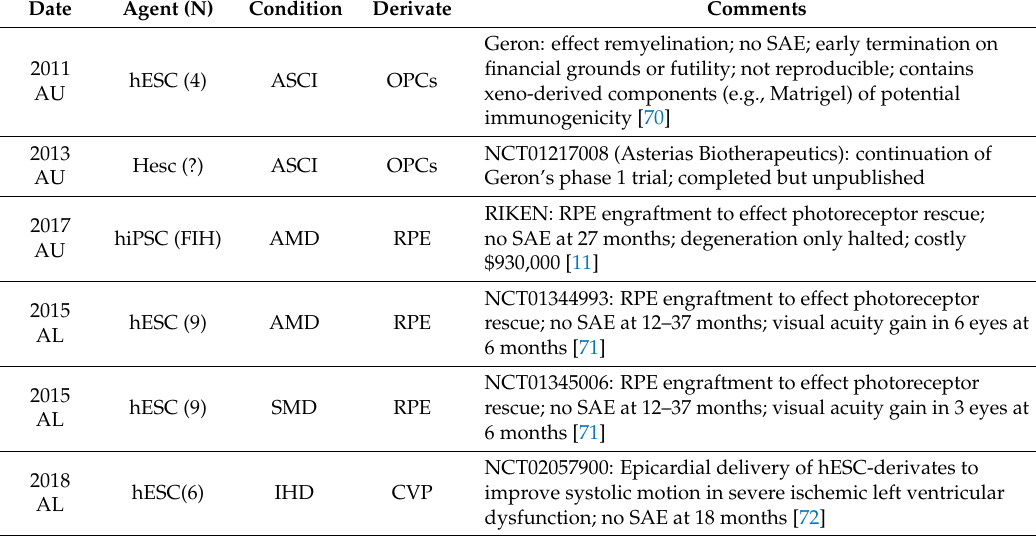
Table 2. Completed clinical trials involving pluripotent stem cells, with number of participants treated (N) and termination date. Trials listed are phase 1 or 1/2. Abbreviations: AL, Allogeneic; AMD, Age-Related Macular Degeneration; ASCI, Acute Spinal Cord Injury; AU, Autogeneic; CD15+ Isl-1+ CardioVascular Progenitors, CVP; First-In-Human, FIH; Ischemic Heart Disease, IHD; Oligodendrocyte Progenitor Cells, OPCs; Retinal Pigment Epithelium, RPE; Serious Adverse Event, SAE; Stargardt’s Macular Dystrophy,